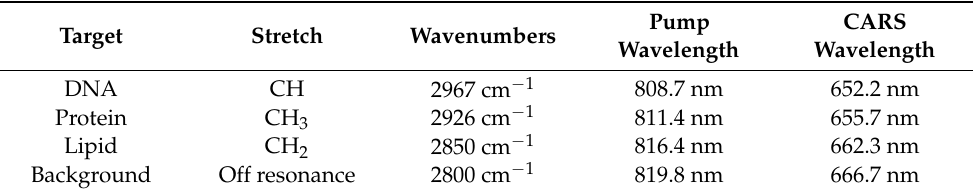
Table 1. The probed vibrations in CARS and the wavelengths involved when using a Stokes beam at 1064 nm.